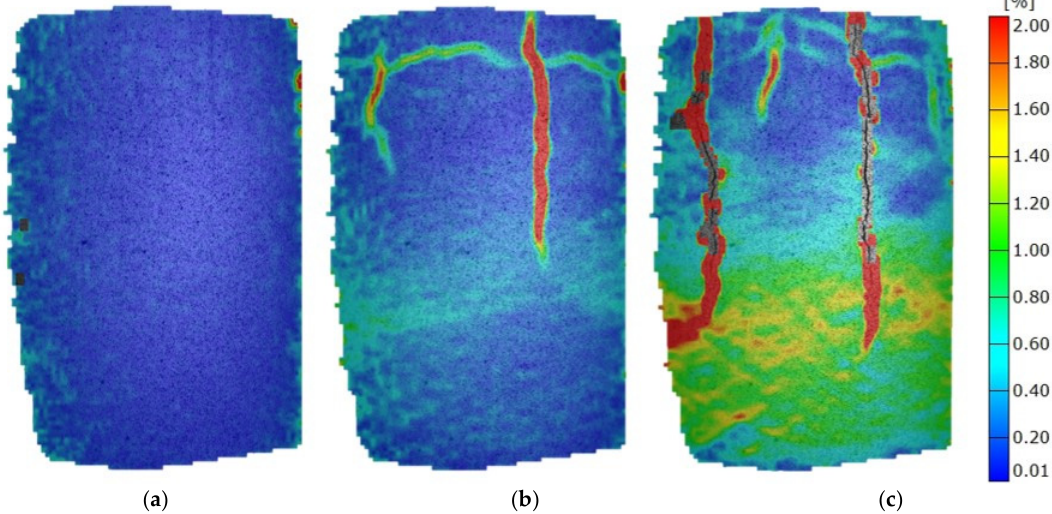
Figure 9. Mises strain at various load stages of mixtures with sunflower fly ash. ( a ) 0.3 F max ; ( b ) 0.6 F max ; ( c ) 1.0 F max .